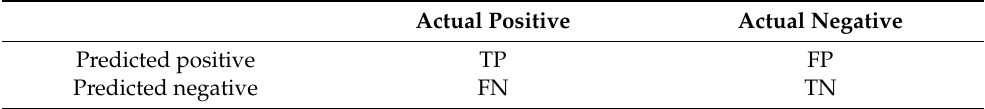
Table 3. Confusion matrix for binary